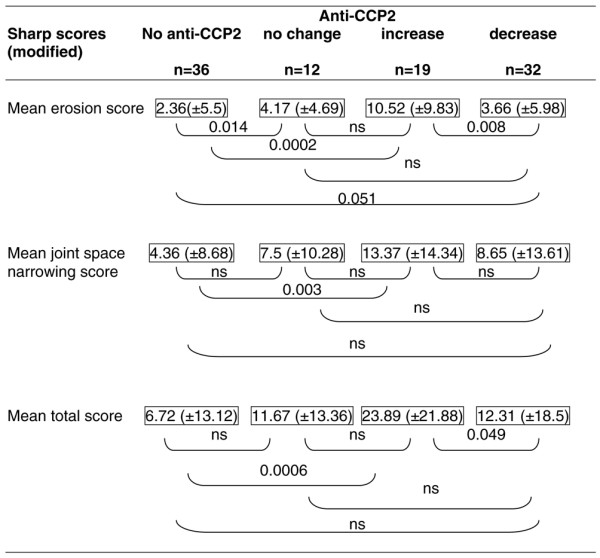
Progression of radiographic Sharp scores (mean ± SD) after five years in patients with or without anti-CCP2 antibodies, according to the change in anti-CCP2 concentrations between baseline and three years.